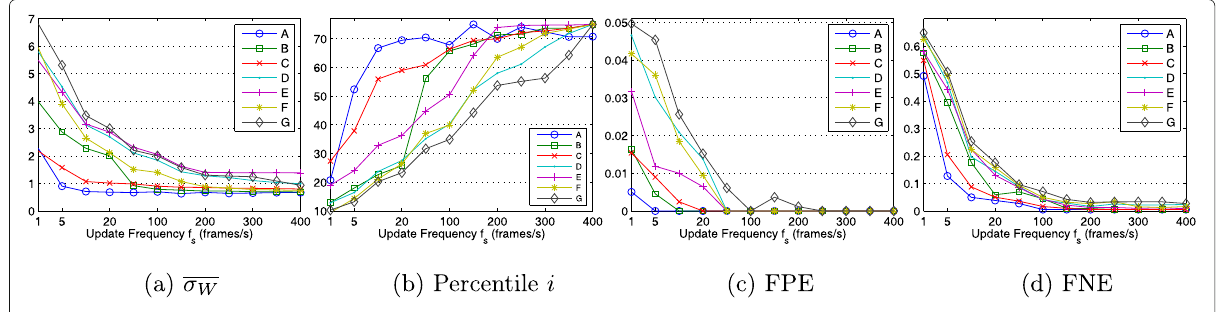
Fig. 8 a shows the average window stability σ W of 7 scenarios for different f s . b shows the percentile i according to σ W . c and d present the corresponding FP and FN error rates using the percentile i shown in b